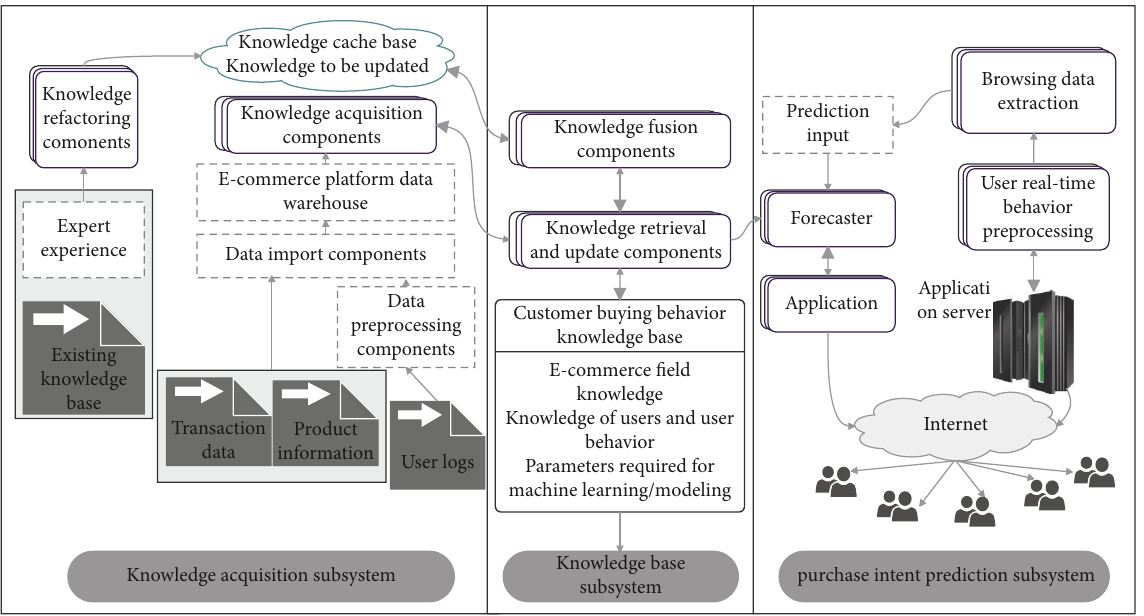
Figure 4: Architecture diagram of e-commerce customer purchase intention prediction